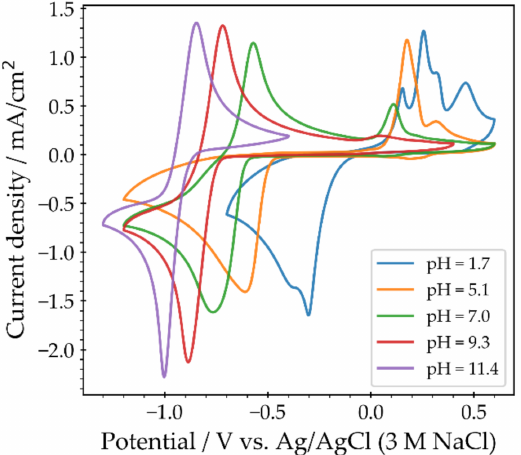
Figure 7. Cyclic voltammetry of pristine quinoxaline on GC in a Britton–Robinson universal buffer solution with added KCl. The pH ranged from 1.7 to 11.4. The voltammograms were recorded at a scan rate of 100 mV/s using a 3 mm diameter glassy carbon disk